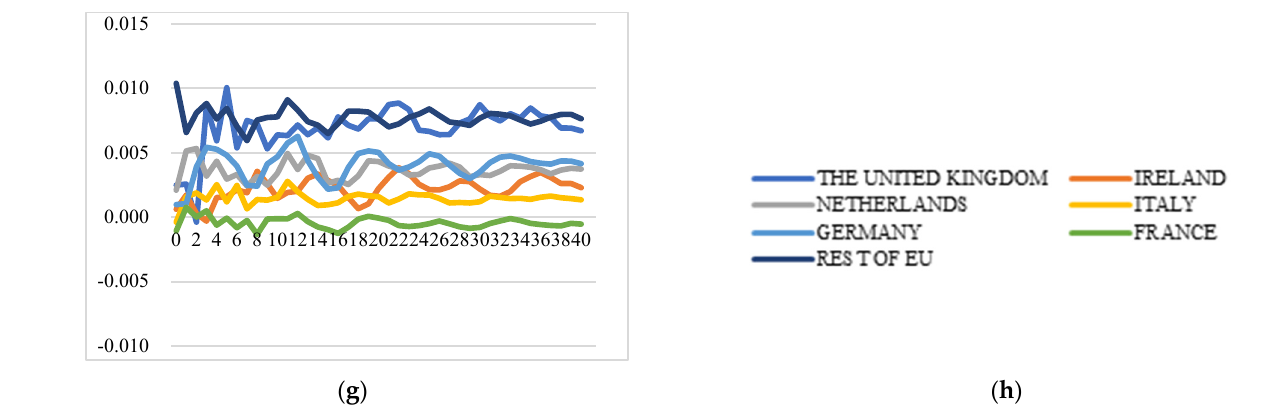
Figure 6. Generalized impulse response functions (GIRFs) of six EU member states’ extra-EU cheese export prices after a positive one-standard-error shock to extra-EU cheese export price (bootstrap median estimates). ( a ) GIRFs after a shock to France’s extra-EU export price. ( b ) GIRFs after a shock to Germany’s extra-EU export price. ( c ) GIRFs after a shock to Ireland’s extra-EU export price. ( d ) GIRFs after a shock to Italy’s extra-EU export price. ( e ) GIRFs after a shock to the Netherlands’ extra-EU export price. ( f ) GIRFs after a shock to the UK’s extra-EU export price. ( g ) GIRFs after a shock to the rest of the EU’s extra-EU export price. ( h ) legend.